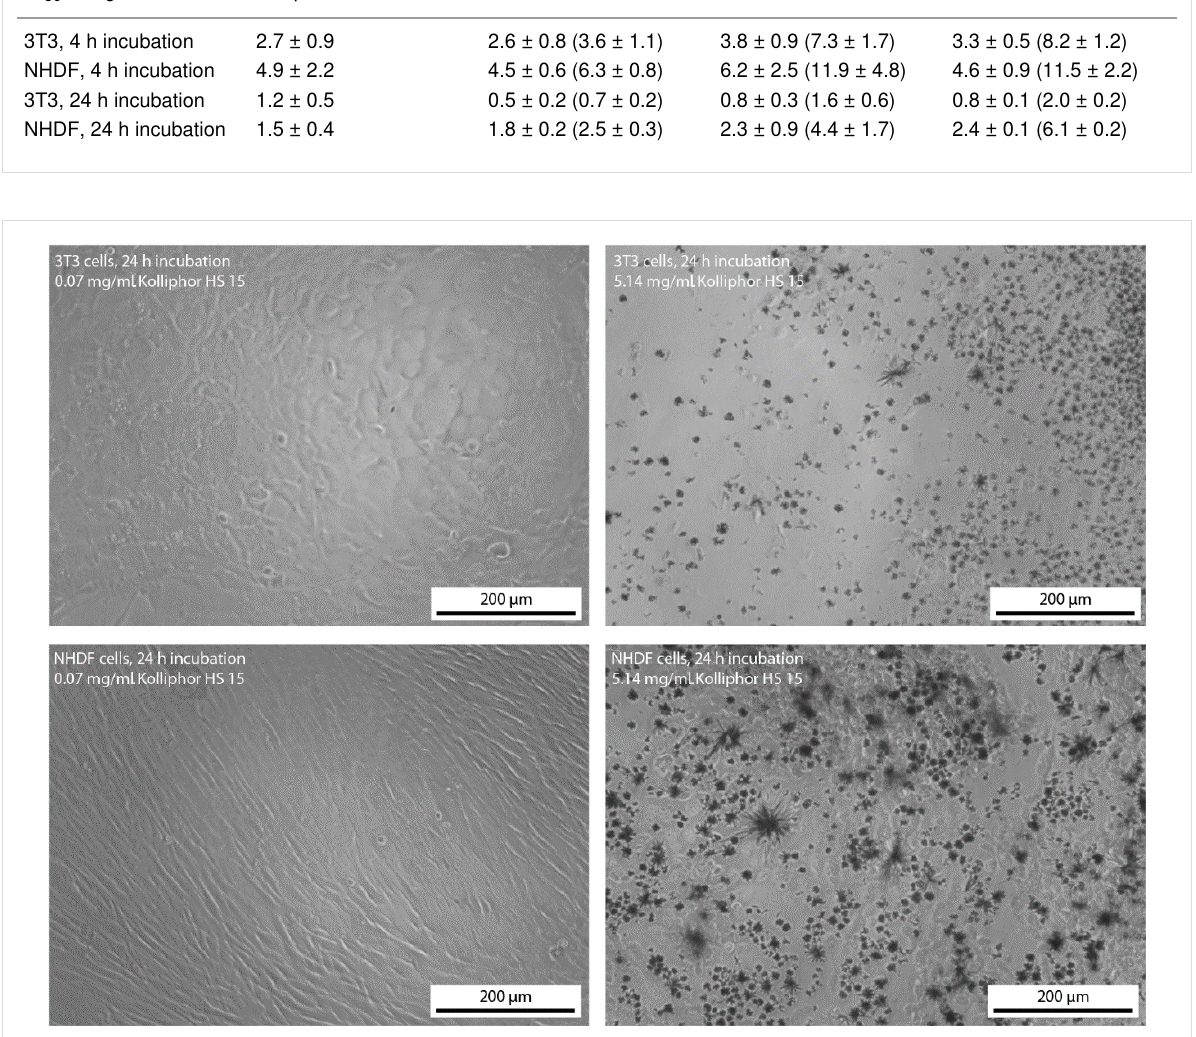
Table 2: Mean inhibitory concentration (IC 50 in mg/mL) of Kolliphor HS 15 in an aqueous solution of Kolliphor HS 15 and IC 50 of Kolliphor HS 15 in the nanoemulsions NE25, NE50 and NE100. The values in brackets refer to the concentration of MCT + Kolliphor HS15 in NE25, NE50 and NE100. IC 50 in mg/mL of: